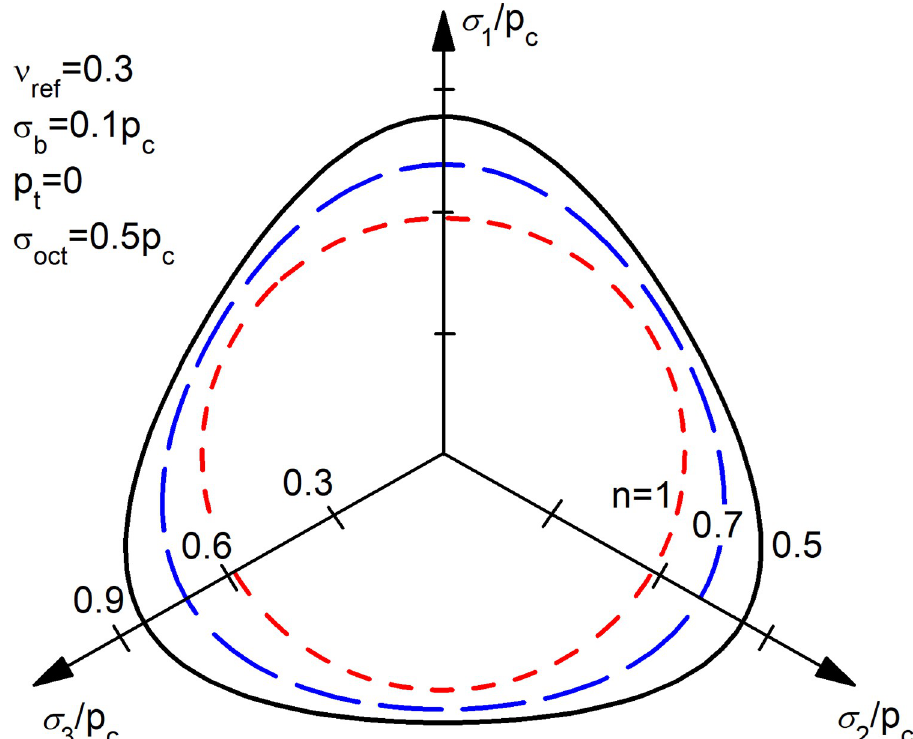
Fig 11. Non-linear elastic potentials in deviatoric